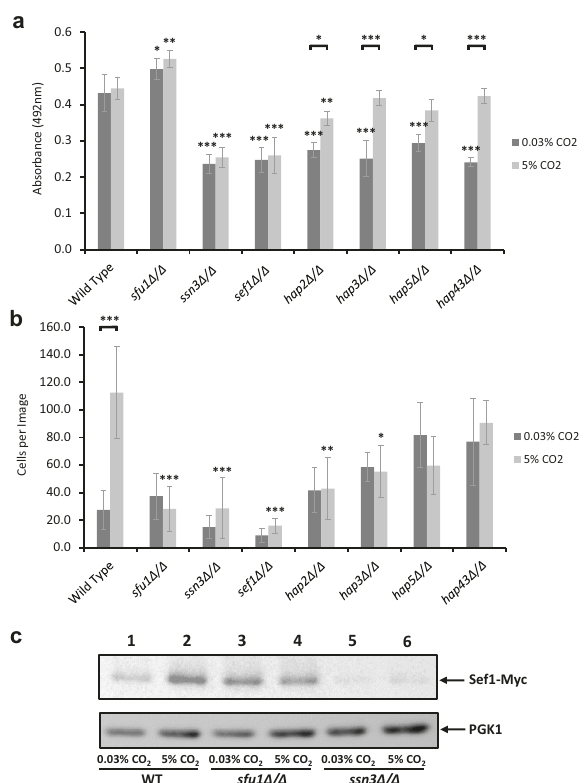
Fig. 4 The effect of high (5%) CO 2 on iron homoeostasis in C. albicans bio fi lms. a Bio fi lm growth assay using iron homoeostatic pathway null mutants. Bio fi lms were seeded and grown for 48 h before XTT quanti fi cation. b Iron homoeostatic mutants were seeded on a silicone surface and the number of attached cells were quanti fi ed from microscopic images. Graphs represent at least three biological replicates each containing technical triplicates, error bars denote standard deviation. Two-way ANOVAs followed by Tukey tests for multiple comparisons were carried out: * p < 0.05, **p < 0.01, *** p < 0.001. c Immunoblot of Sef-Myc and PGK1 (internal standard) from 48 h bio fi lms in wild-type, sfu1 Δ / Δ , and ssn3 Δ / Δ backgrounds.